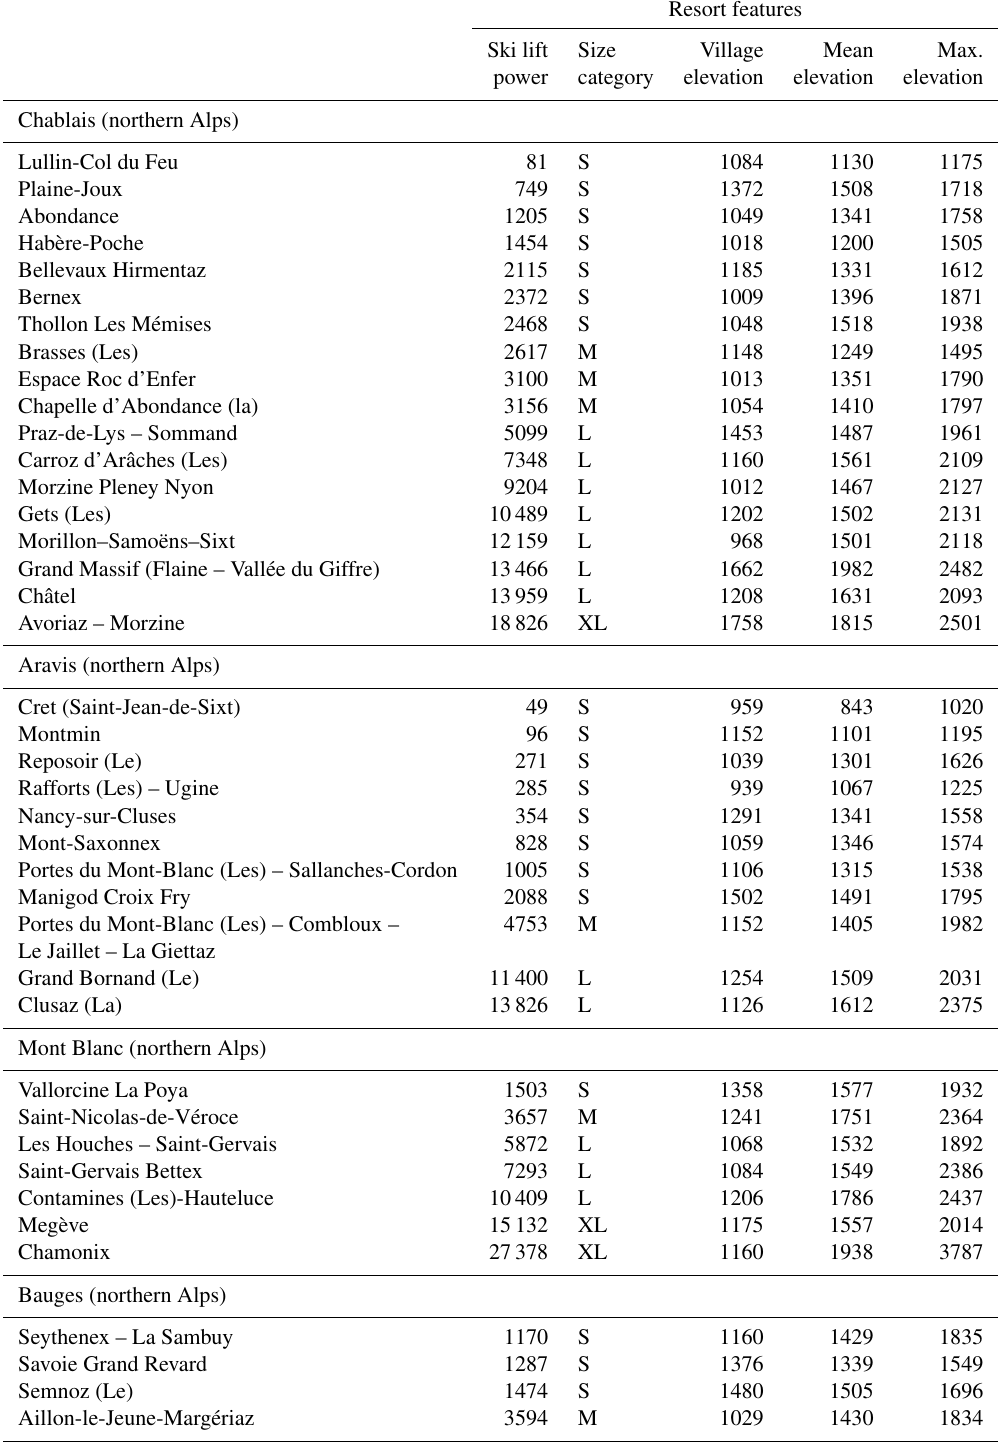
Table B1. Main features of the 175 ski resorts included in the present work grouped by massifs and major areas (northern and southern Alps, French and Spanish and Andorran